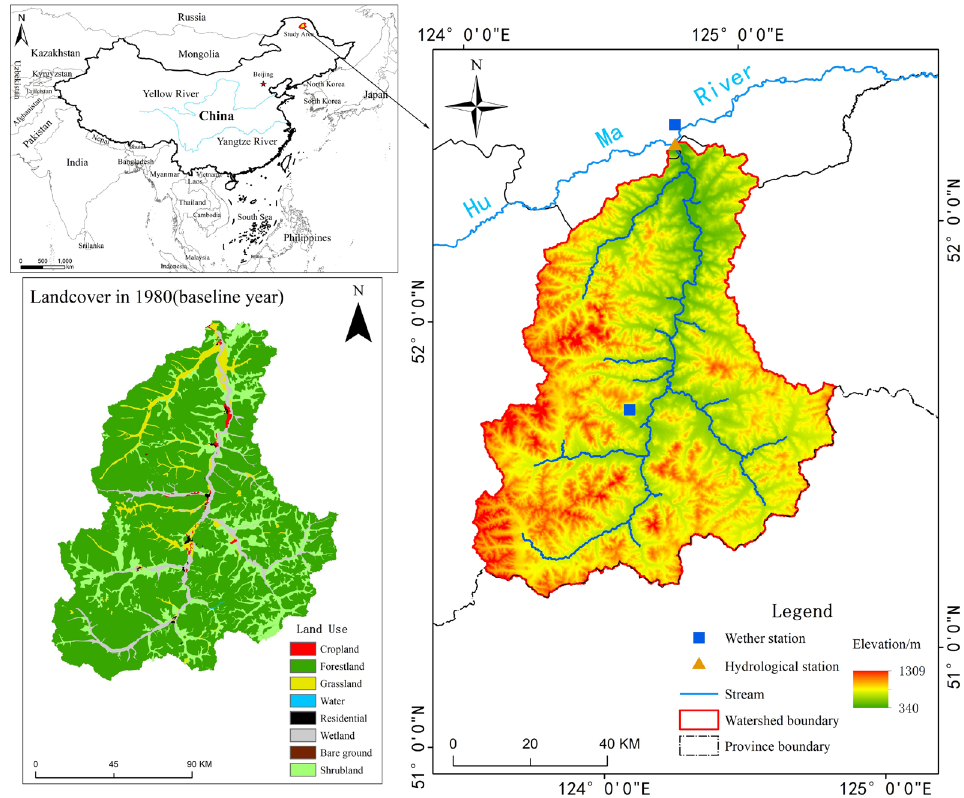
Figure 1. Location and distribution of hydrometeorological stations and landcover in 1980 (baseline year) in the study area.